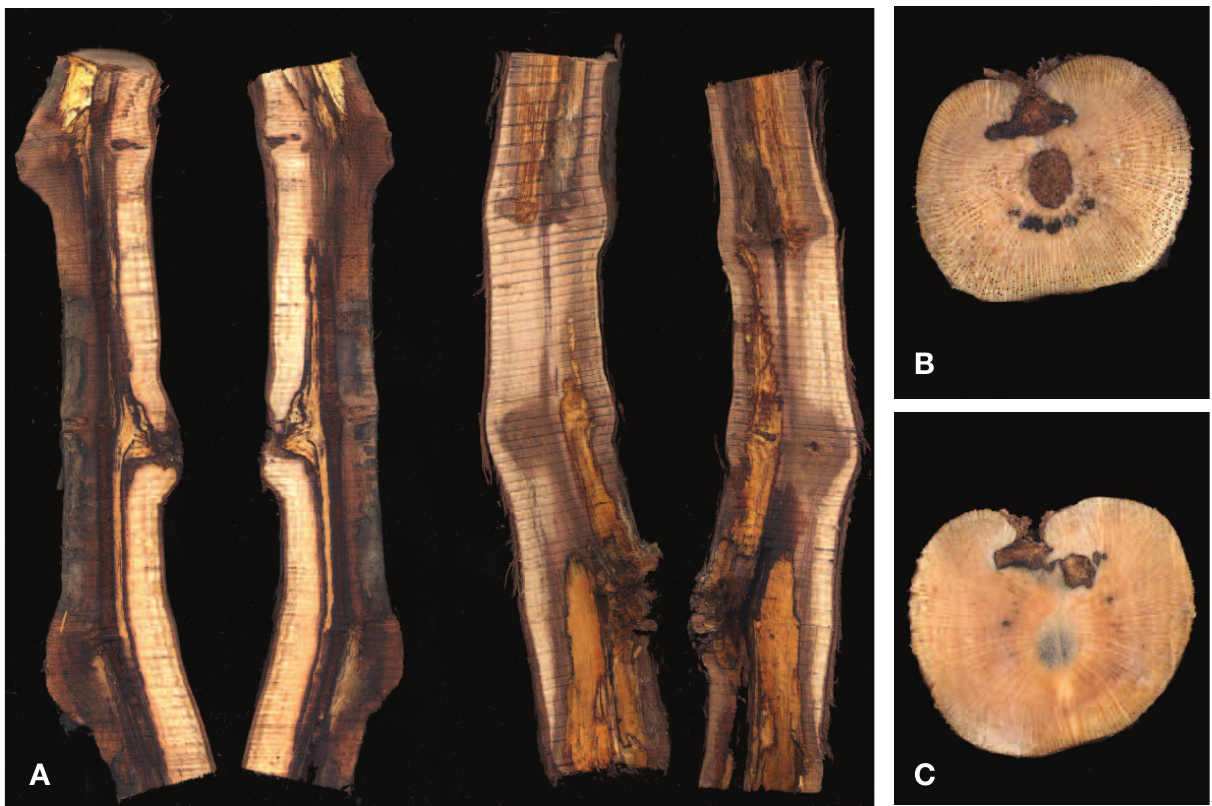
Fig. 3. A. Longitudinal sections of portions of trunk from grapevines which were symptomatic in the year they were uprooted. The figures show large portions of the wood with white decay and dark necrosis. In these vines the up- ward movement of the sap is through a very small portion of still functioning wood. B and C. cross sections of a trunk from grapevines which were symptomatic in the year they were uprooted. The figures show small areas of necrotic and rotted tissues near injuries caused by sucker